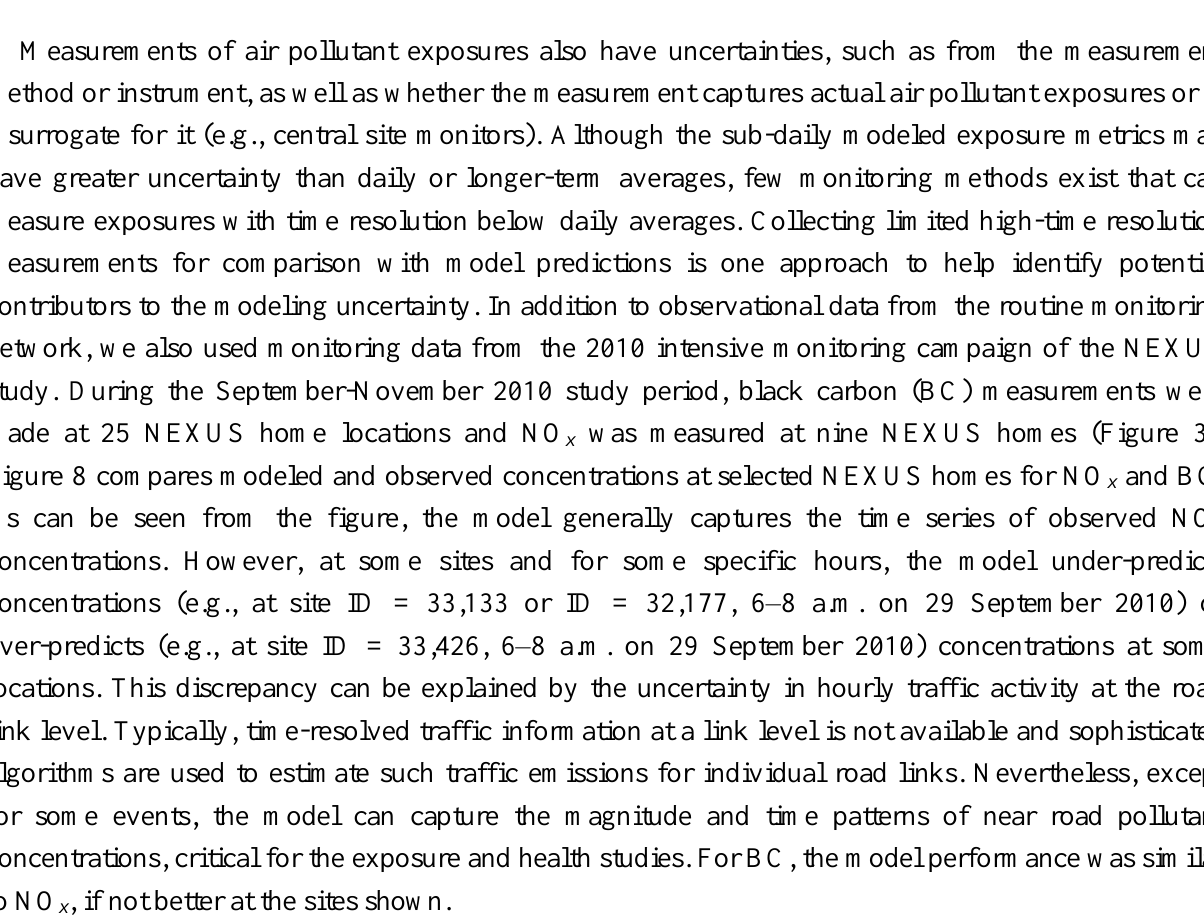
and PM concentrations (2010 annual x 2.5